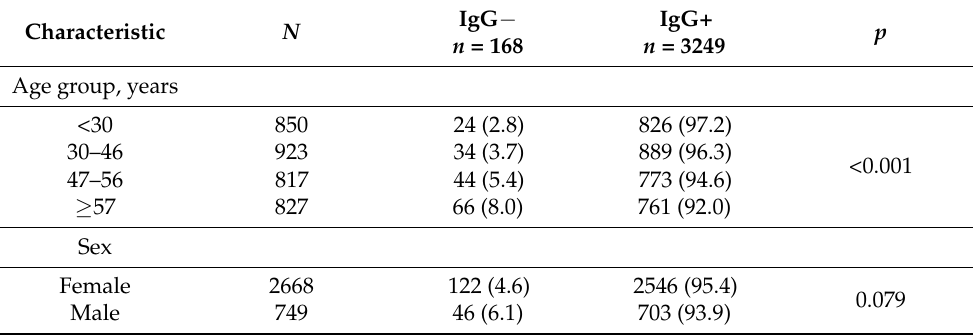
Table 5. Characteristics of participants by age, sex and immune response.